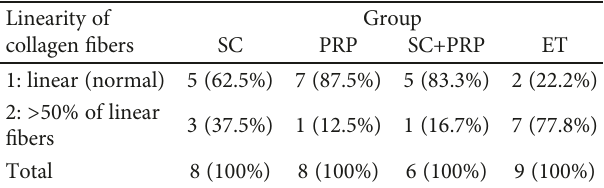
Table 5: Analysis of collagen fi ber linearity.